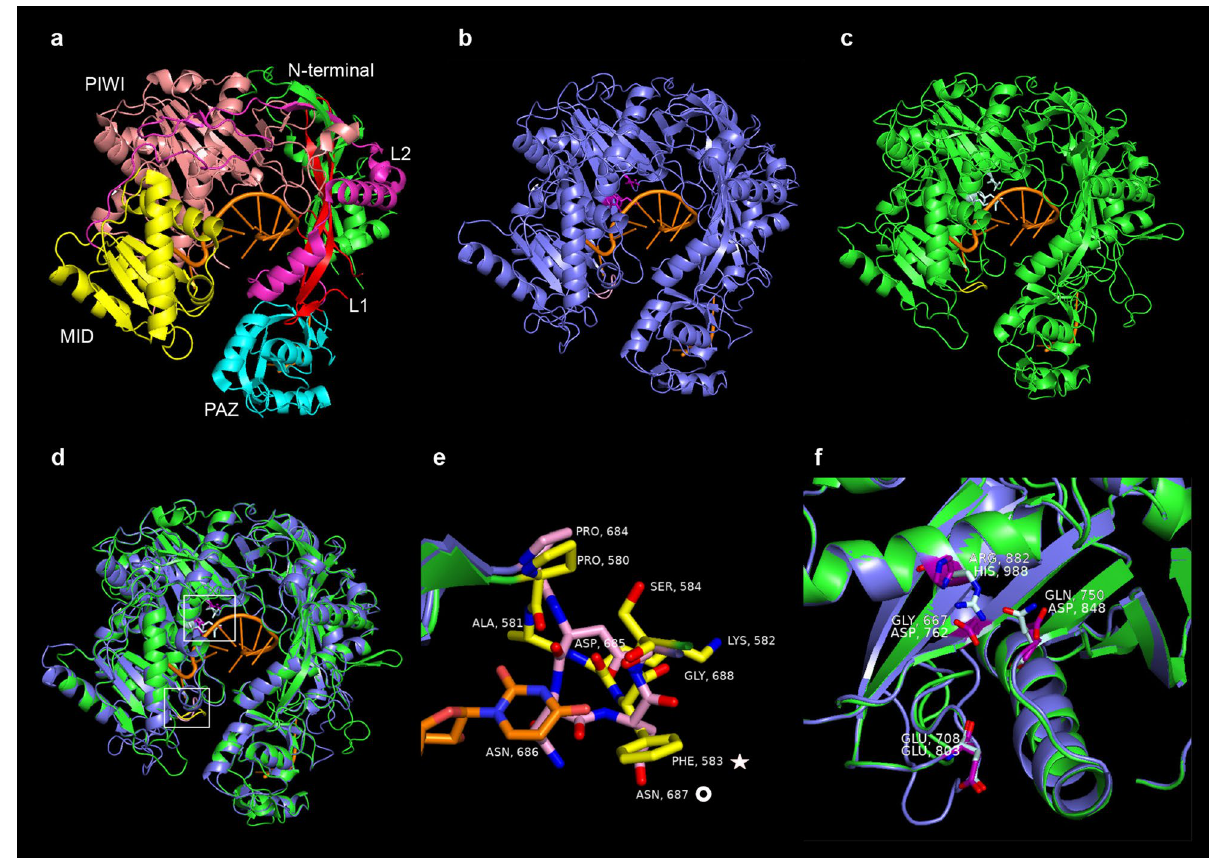
Figure 4. Three-dimensional AGO protein structure predictions. ( a ) Crystal structure of the human AGO2- miR-20a complex. N-terminal = green, L1 = red, PAZ = cyan, L2 = magenta, MID = yellow, PIWI = salmon. ( b ) AtAGO1 (steel blue) and Hs-miR20 (orange, PDB ID 4F3T:R). Residues of the D-E-D-H motif are in purple. The nucleotide specificity loop (NSL) in pink. ( c ) StAGO15 (green) and Hs-miR20 (orange). Residues of the G-E-Q-R motif in light cyan. The NSL in yellow. ( d ) Figure b and c merged. ( e ) Close view of the NSL in figure d (upper square). Nitrogen (red) and oxygen atoms (blue). The replacement of Asparagine (ASN, 687) in AtAGO1 to Phenylalanine (PHE, 583) in the StAGO15 NSL is highlighted with a white star (PHE, 583) and a white ring (ASN, 687). ( f ) Close view of the D-E-D-H/G-E-Q-R motives in figure d (lower square, Hs-miR20 removed). Nitrogen (red) and oxygen atoms (blue). StAGO15 residue labels are placed above the AtAGO1